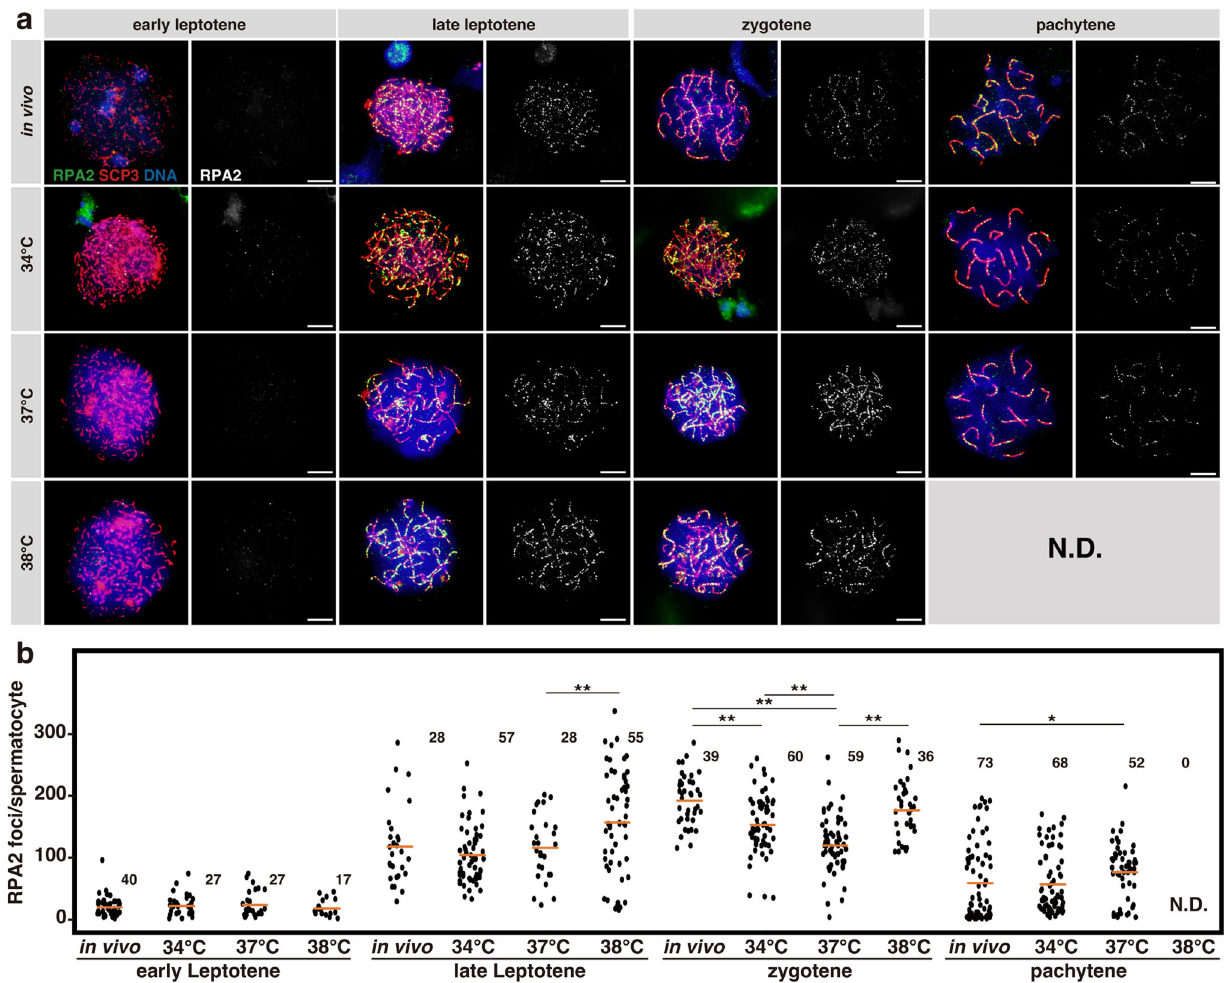
Fig. 5 Evaluation of RPA foci formation at different temperatures. a Representative images of chromosomal spreads in meiotic prophase I substages, prepared from the testes of 5-week-old Acr-GFP mice and testis explants cultured for 5 weeks at 34, 37, or 38 °C. Samples were stained for RPA2 shown in green, with SCP3 (red) used for staging and DNA (blue). RPA2 signals are shown separately in the right panels. Scale bars, 10 μ m. b Dot plots showing the number of RPA2 foci associated with SCP3 + chromosome axes in each spermatocyte of the indicated substage prepared from the in vivo and ex vivo testis samples. Each dot represents an individual spermatocyte with means indicated as horizontal bars. The number of spermatocytes analyzed are indicated above the plots (N.D. not detected). Cells prepared from three testes from different individuals (in vivo ) and 8 (34 °C), 8 (37 °C), and 8 (38 °C) explants were pooled and analyzed. Multiple comparisons were conducted using the Kruskal – Wallis test among all values within each category and gave p -values of 0.88, 1.39E-3, 1.13E-11, and 0.02, respectively, for early leptotene, late leptotene, zygotene, and pachytene. The Steel – Dwass test was applied for combinations of two values within each category resulting in the p -values as indicated in the plots (* p < 0.05, ** p <